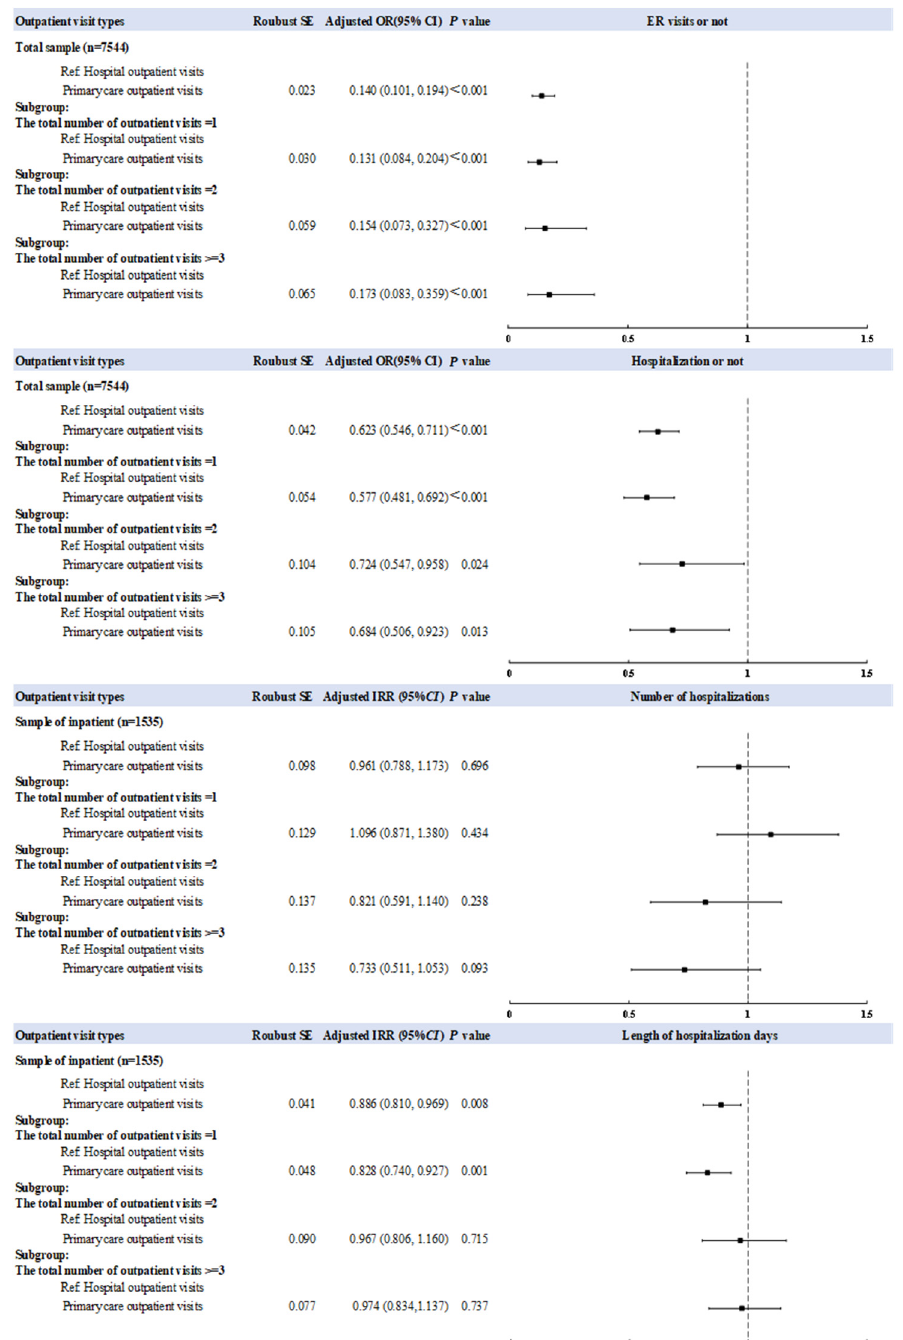
Figure 3. Forest plot of the association between the outpatient visit types and ER or hospital inpatient utilization. All models were adjusted for economic region, PGDP, current residence,